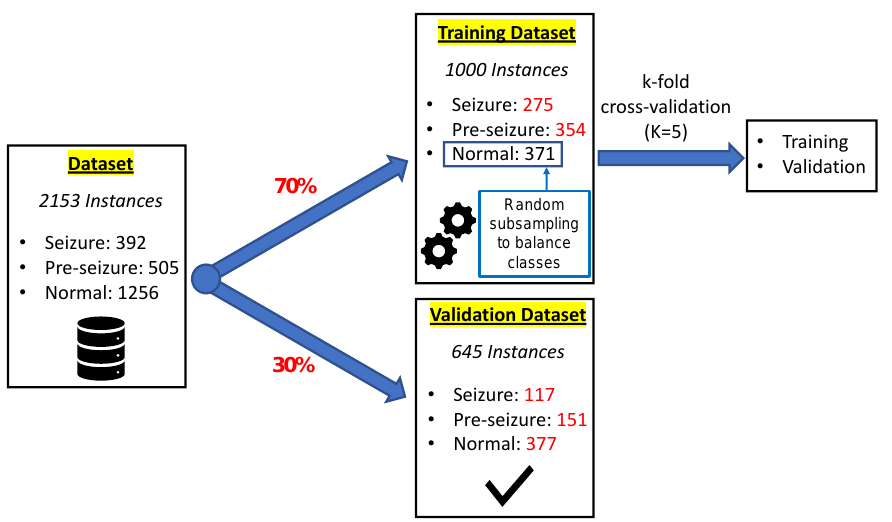
Figure 6. Schematic of the composition of the dataset used in the training and validation of the